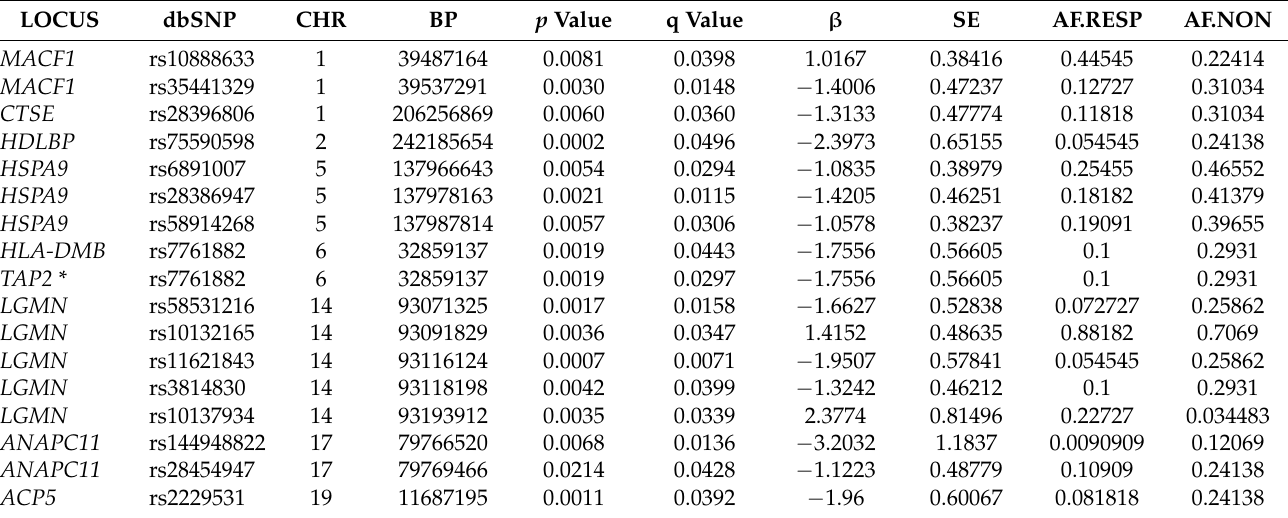
Table 2. Independent statistically significant